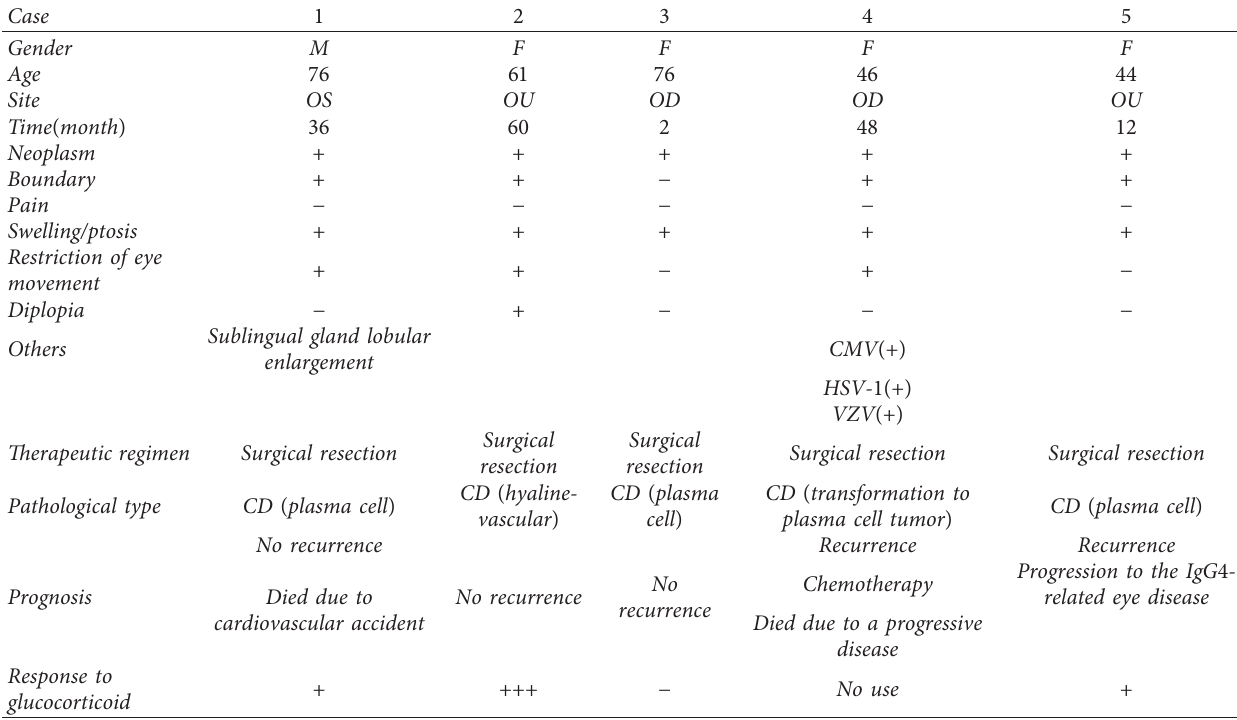
Table 1: Clinical manifestations of 5 patients with CD of the lacrimal